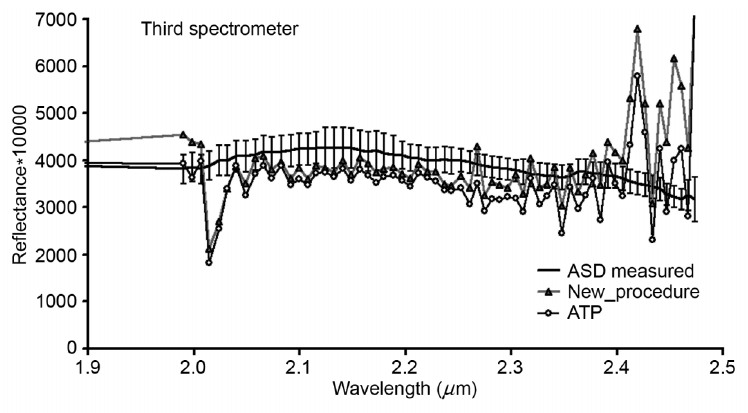
Fig. 7. Comparison of APT and new calibration spectrum of the AOI in concrete with respect to ASD re- flectance. ASD measure is plotted with one sigma errors